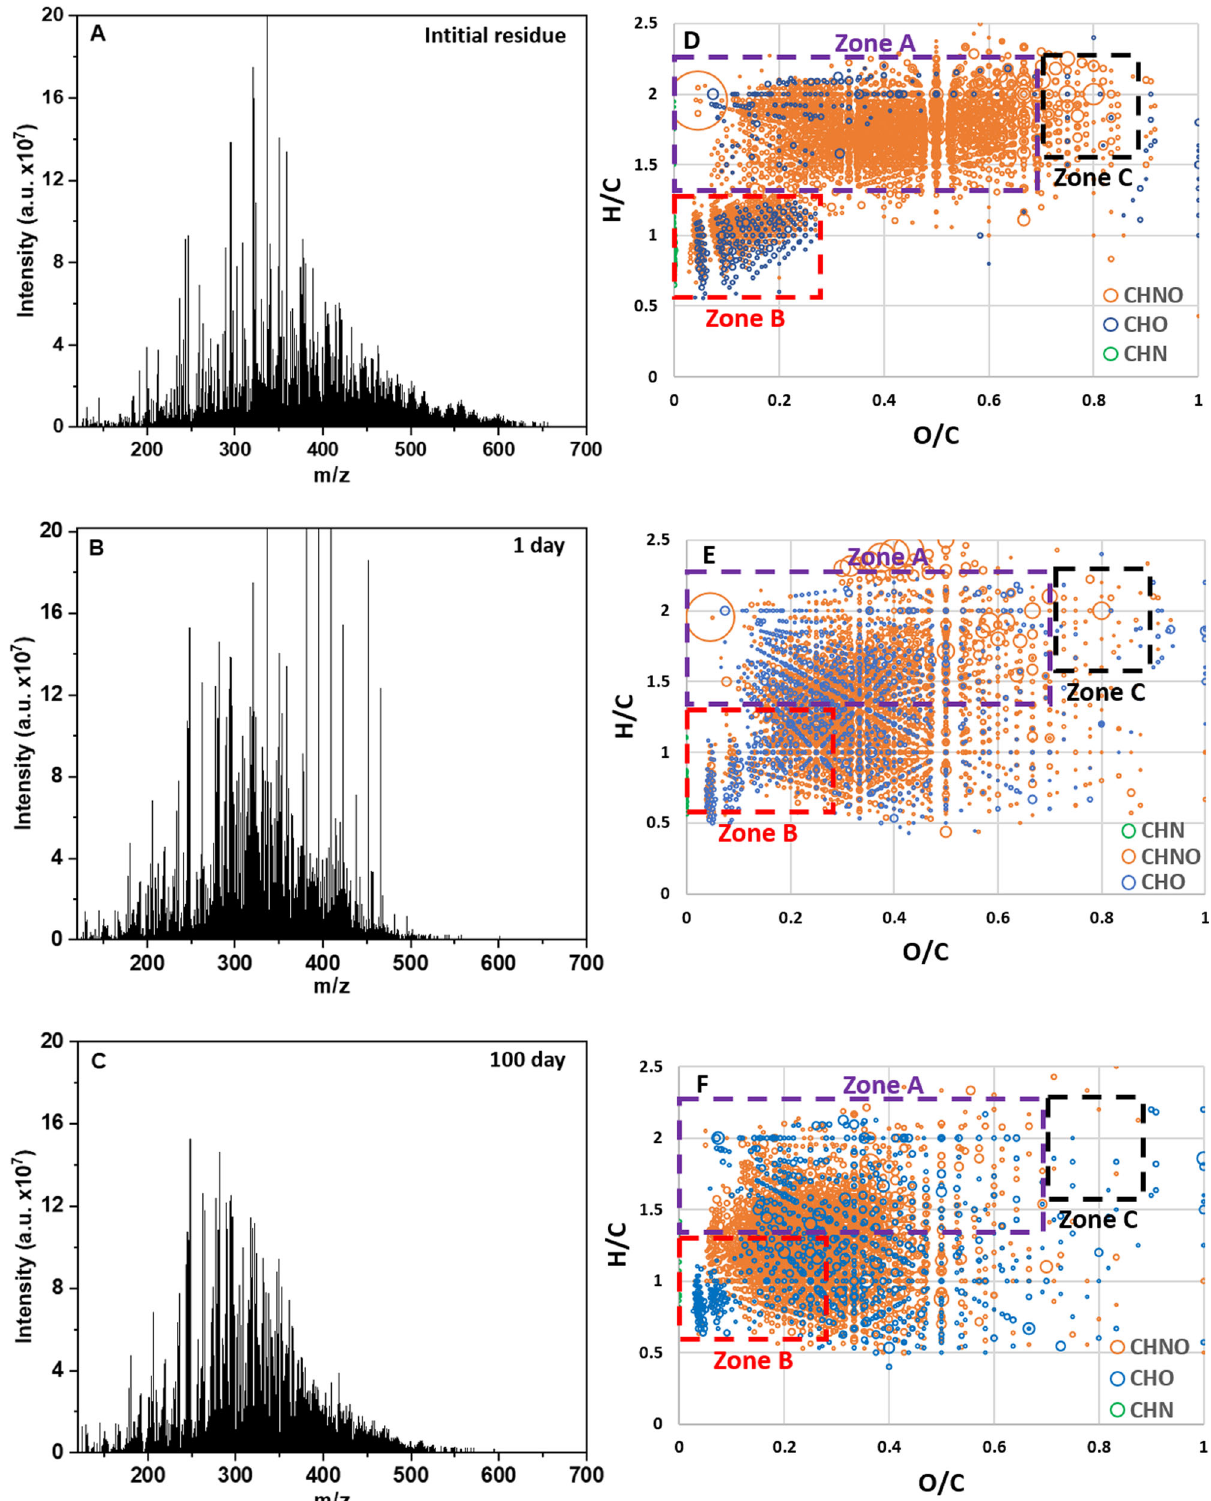
Fig. 1 Mass spectra and Van Krevelen representations of the samples. A , D The pre-accretional organic residue (3964 molecular attributions), B , E The post-aqueous organic product after 1 day at 150 °C (3808 molecular attributions), and C , F The post-aqueous organic product after 100 days (3424 molecular attributions). The size of the circle representing each molecular attribution is proportional to ion intensities. Molecular families of these molecular attributions are colored in green for CHN, orange for CHNO, and blue for CHO. On the Van Krevelen representation are delimitated areas corresponding to aliphatic groups (Zone A), aromatic groups (Zone B), and aliphatic enriched in O groups (Zone C). H/C vs N/C diagrams corresponding to CHNO, CHO, and CHN families separately are displayed in Supplementary Fig. 2 – 13.